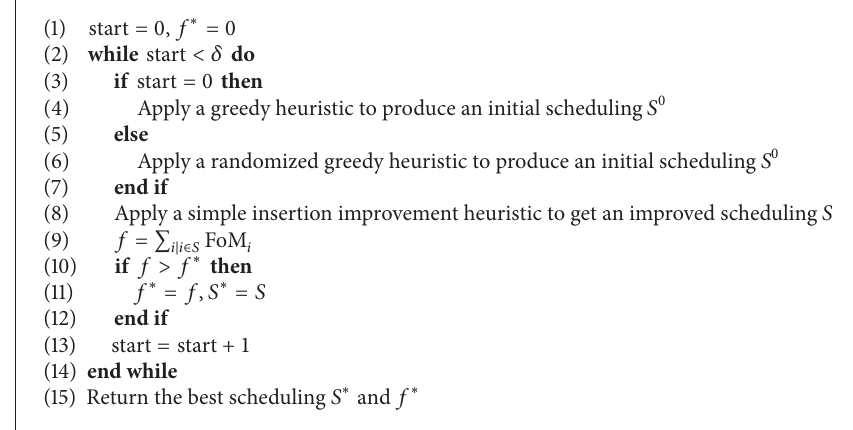
Algorithm 1: Pseudocode of GRASP for the SIAS problem.